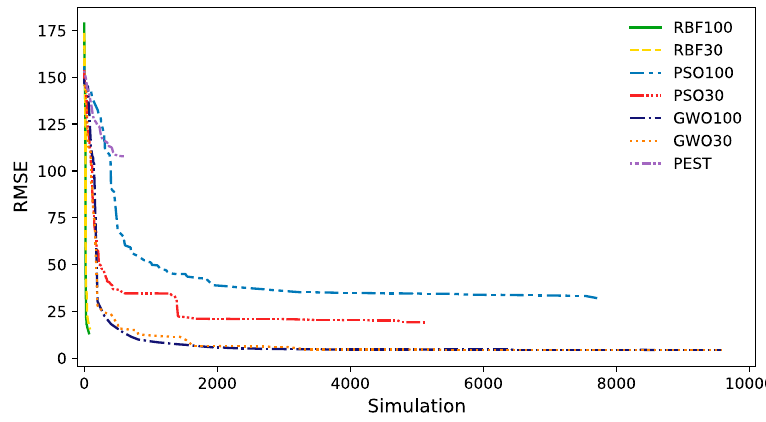
Figure 4. Running improvements of the mean of 15 runs by optimizer/agent size pairing.